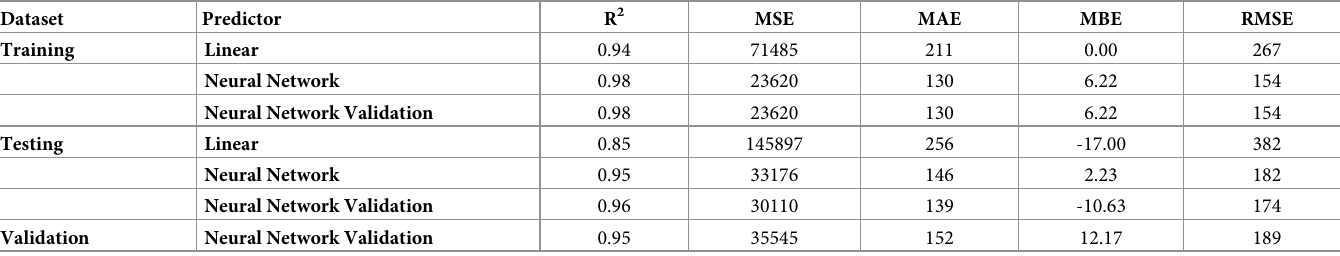
Table 19. Performance of neural network and linear regression compared to real stock market.